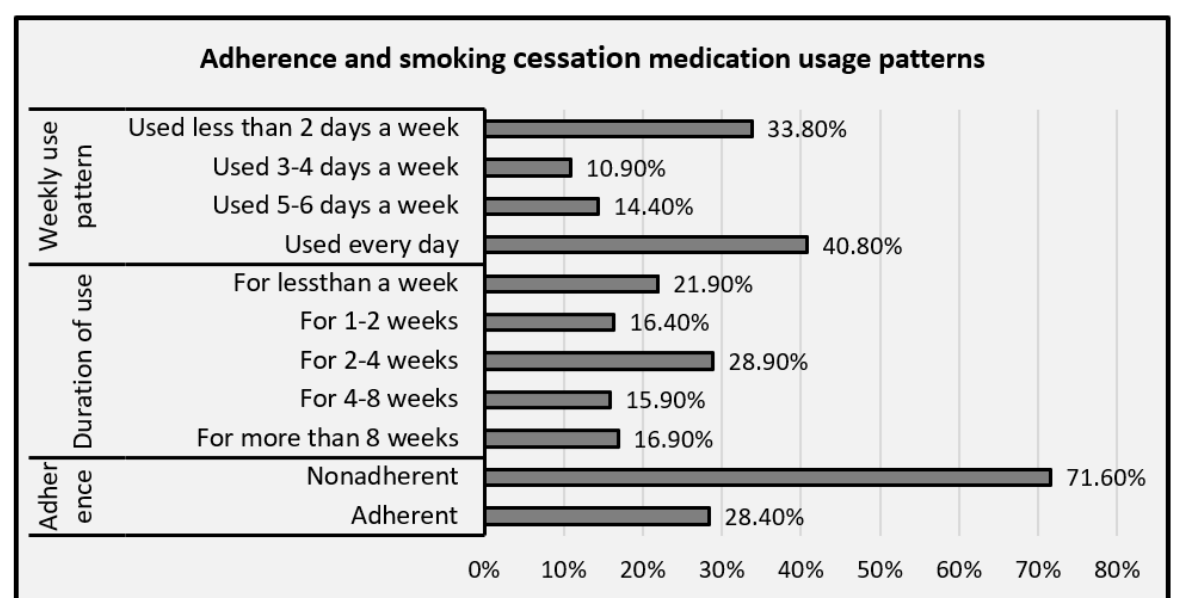
Figure 1. Adherence and smoking cessation medication usage patterns.